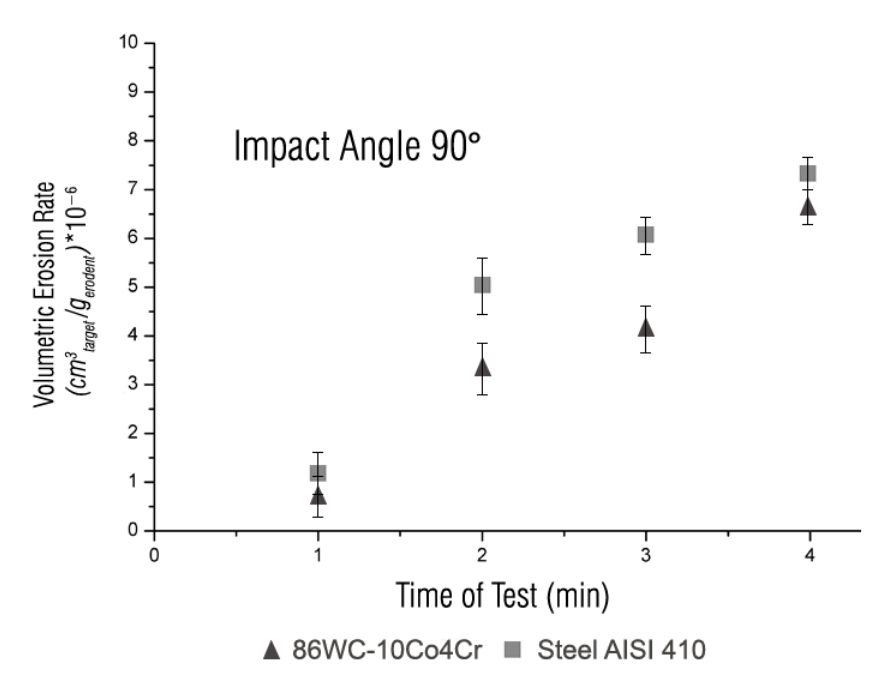
Figure 10. Variation of the accumulated volumetric erosion rate as a function of the impact angle of 90 ◦ for the martensitic stainless steel (AISI 410) and tungsten carbide (86WC-10Co-4Cr) coating.